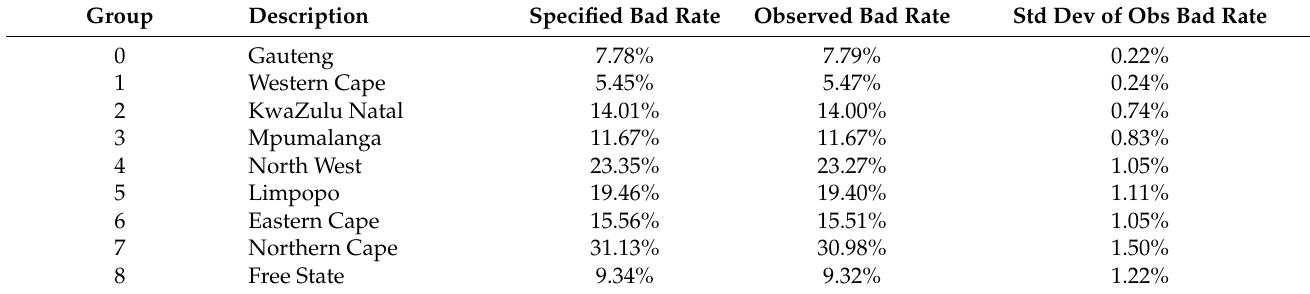
Table A8. Province of residence.